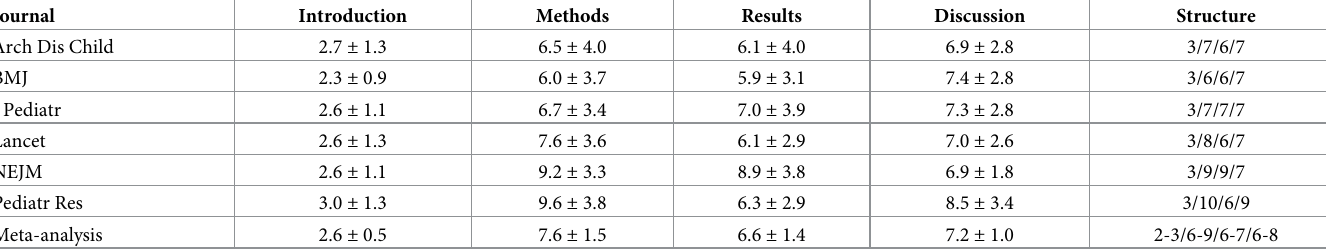
Table 1. Means and standard deviations for number of paragraphs per section. Modified from Albert [2], Fig